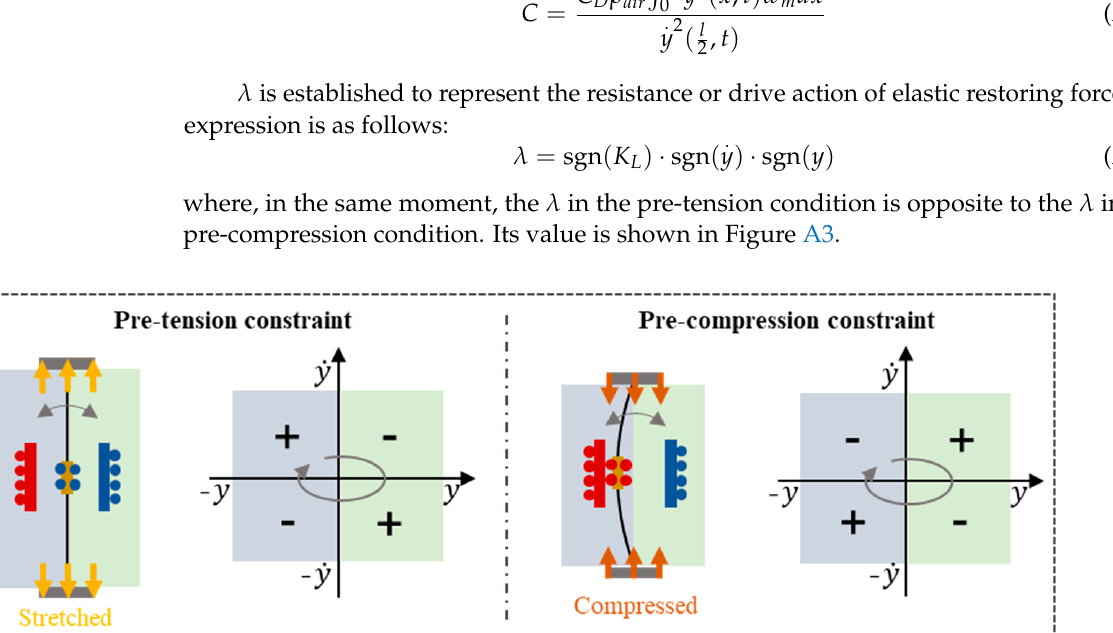
15 of 17 In this paper, the parameters in the elastic restoring force calculation are shown in Table A2. Table A2. Structure parameters of the simulation model. Parameters used to calculate 𝑭 𝑴 Value Microbeam width 𝑤 (cid:3040) .